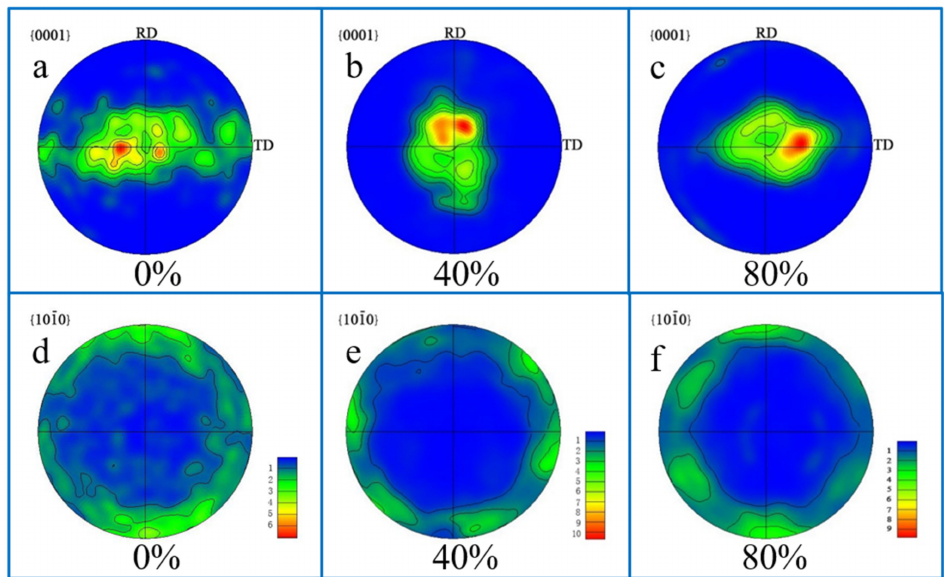
Figure 4. Pole figure of cold-rolled TA2 with different degrees of cold-rolled deformation: ( a , d ) 0% deformed, ( b , e ) 40% deformed, ( c , f ) 80%